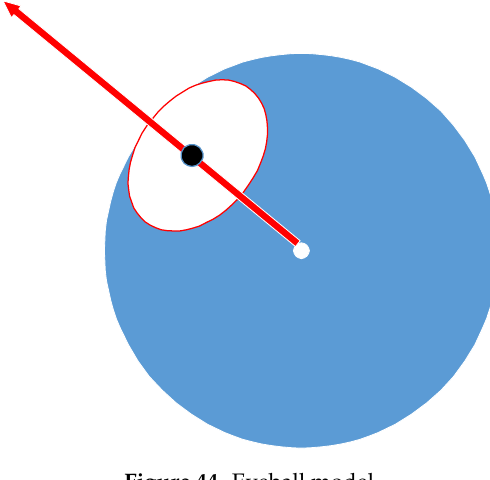
Figure 44. Eyeball model. Figure 44. Eyeball